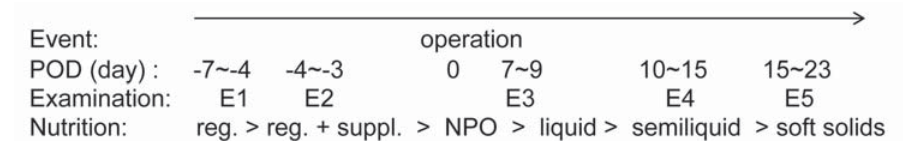
Figure 2- Protocol of oral examination during the perioperative period of esophageal cancer surgery. Abbreviations are as follows: POD: postoperative day; reg.: regular meal; suppl.: additional enteral nutrient; NPO: Nil per